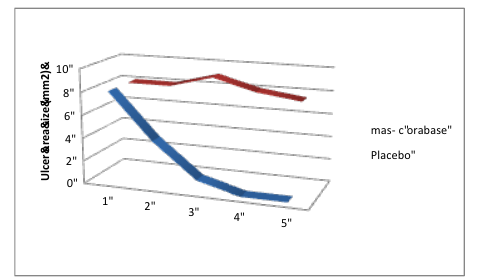
Fig.1: Ulcer area of rabbits’ cheek pouches of mastic orabase treated compared to placebo group, level of significance p< 0.05.